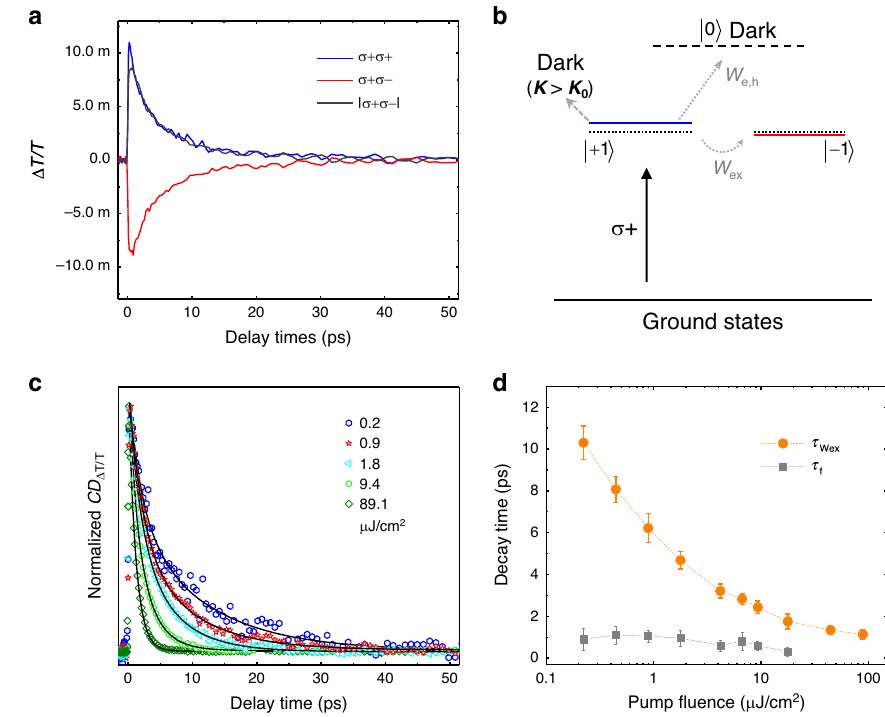
Fig. 3 Exciton spin relaxation dominated by the electron – hole exchange interaction. a The σ + σ + and σ + σ − TA kinetics probed at ~2.35 eV, extracted from Fig. 1b, c, respectively. The gray curve shows the absolute value of the σ + σ − TA kinetics. b The schematics of possible spin depolarization mechanisms for photo-injected + 1 excitons. The W e,h represents the spin fl ip of electron or hole, and W ex is the electron-hole exchange interaction. K and K 0 are the momentum of excitons and light, respectively. The horizontal dotted lines indicate the originally degenerate spin states. Following photoexcitation with a σ + laser pulse, + 1 exciton states shows a large blueshift (blue line) and − 1 exciton states exhibits a slight redshift (red line). c Normalized kinetics of the circular dichroism signal CD Δ T / T , which is de fi ned as Δ T/T σ + σ + , Δ t − Δ T / T σ + σ − , Δ t and averaged in the probed energy range of 2.32 – 2.38 eV. The colored symbols are experimental results at different pump fl uence, fi tted with bi-exponential decay curves (black lines). d The spin decay times extracted from c as a function of pump fl uence. The τ Wex is the exciton spin decay times due to e – h exchange interactions, while τ f is the initial fast-decay component as discussed in the text. The dashed lines are guide for the